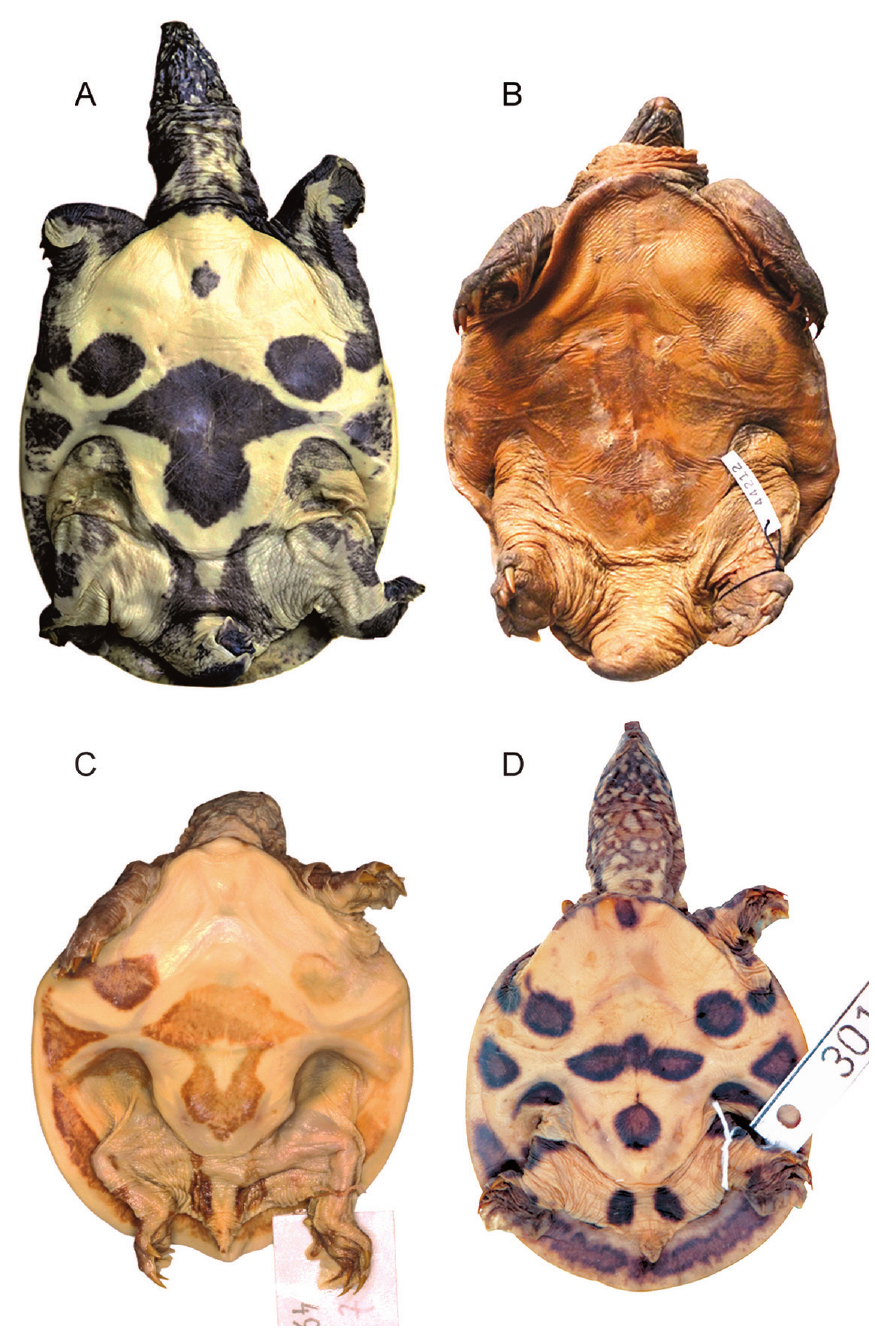
Figure 4. Variation in plastral ornamentation of Pelodiscus variegatus sp. n. A HNHM 2018.111.1, adult male, 109.7 mm PL B ZFMK 44212, adult male, 114.4 mm PL C juvenile, ZMB 49776, 50.0 mm PL D hatchling, AMNH 30125, 37.2 mm PL. Not to scale. Photographs Balázs Buzás ( A ), Balázs Farkas ( B ), Frank Tillack ( C ), Lauren Vonnahme ( D